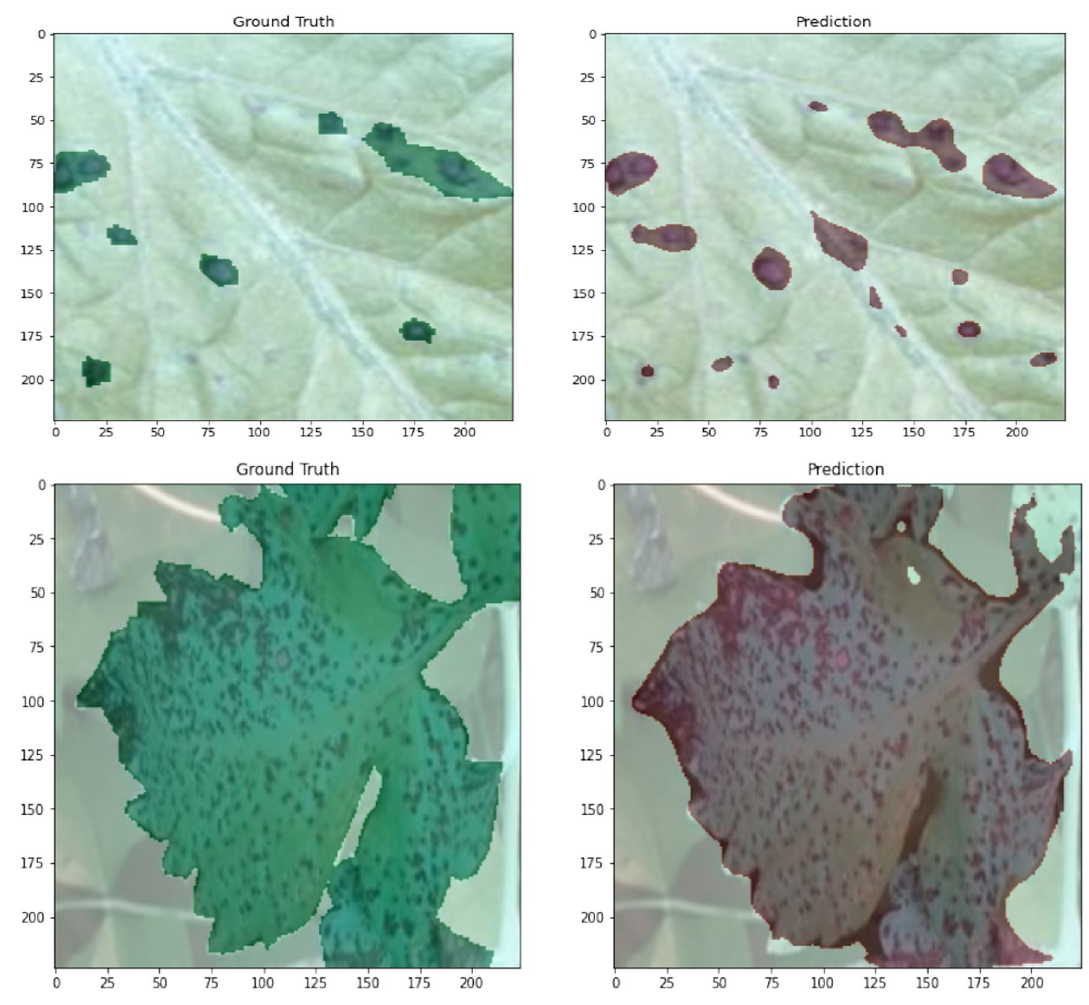
Fig. 2 Visual segmentation results of some images of UNet